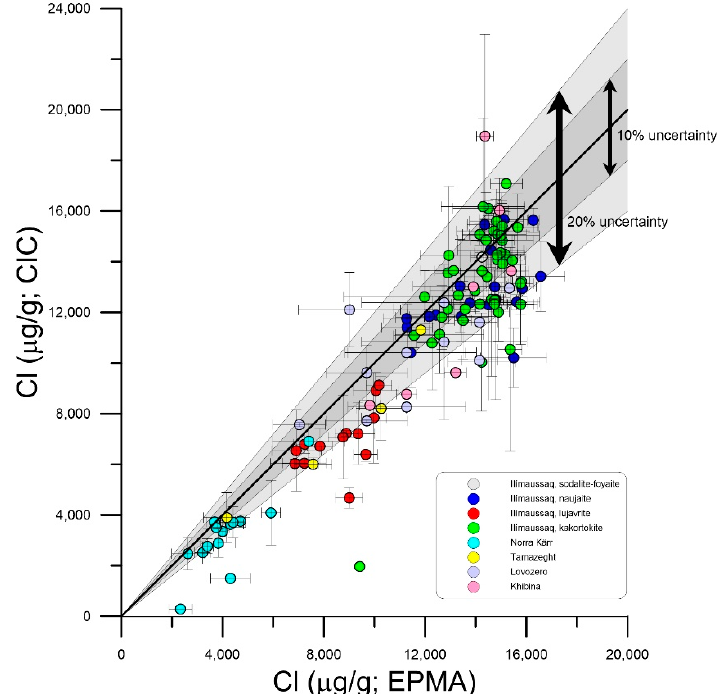
Figure 2. Comparison between Cl concentrations in eudialyte-group minerals (EGM) measured by Combustion Ion Chromatography (CIC) (bulk) and EPMA (spatially resolved), with 10% and 20% uncertainty envelopes. Strong deviations between the two methods indicate impurities in hand-picked mineral separates. Samples outside the 20% uncertainty range have not been considered further in the discussions in this paper.